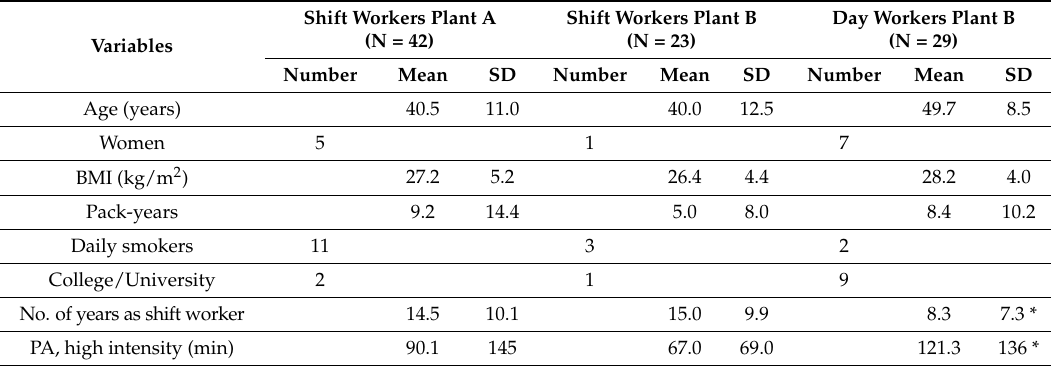
Table 1. Demographic characteristics among shift and day workers (N = 94) participating in the